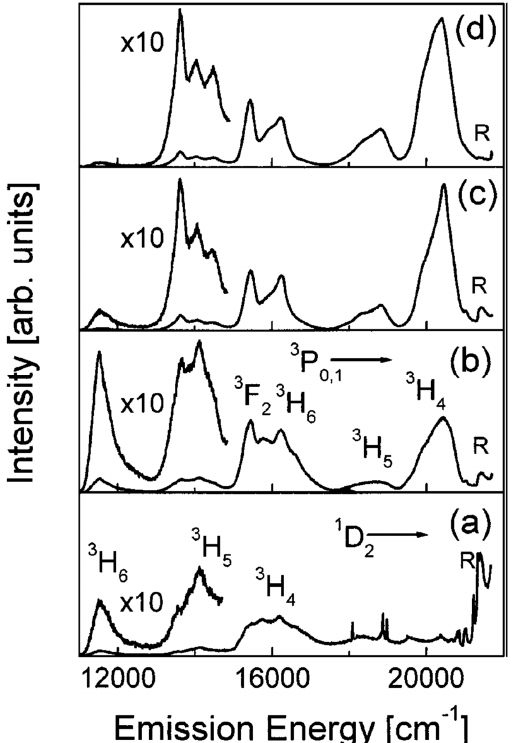
Figure 3. Room-temperature (RT) luminescence spectra of the 500 ( a ), 10,000 ( b ), 20,000 ( c ), and 100,000 ( d ) Pr/Si ppm doped silica xerogels. Excitation was at 457.9 nm. The main emissions from the 3 P 0; 1 and 1 D 2 states are indicated. R labels the Raman band at 430 cm − 1 . Reproduced with permission from [35], copyright 1969, Kluwer Academic Publishers.